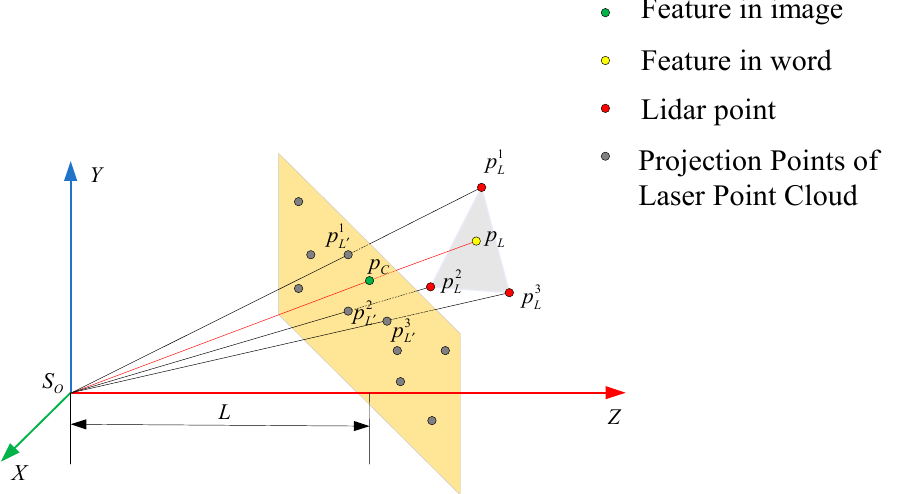
Figure 4. Schematic diagram of image feature correlation depth. The yellow plane represents the image normalization plane. The green dot represents the feature point of the image to be processed. The gray dot represents the laser point projected to the normalization plane. The red dot represents the laser point in the world coordinate system. The yellow dot represents the visual feature in the world coordinate